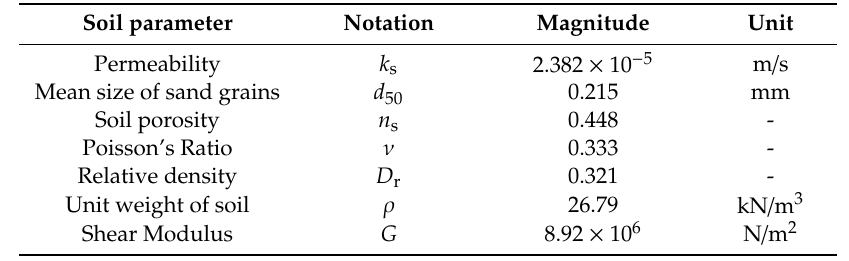
Table 1. Soil properties for experiments and numerical models.